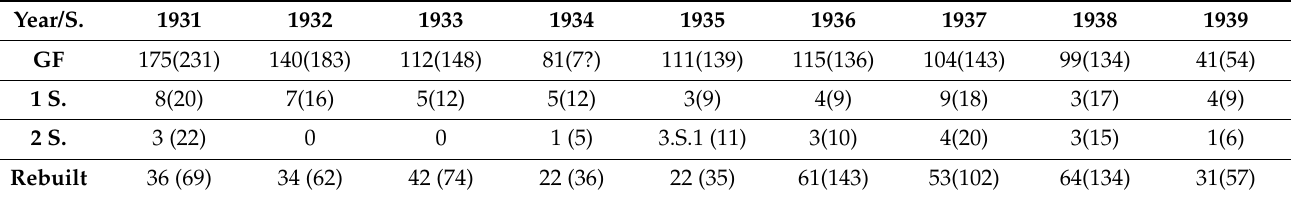
Table 1. From 1931 onwards, the number of completed buildings with an issued residence permit. The number of dwellings is in brackets. Ground floor (GF); the number of floors (S); rebuilt (actual reconstruction or extension of the building for residential purposes). Source: (Fels˝omagyarorsz á gi Reggeli Hirlap 1940, p.